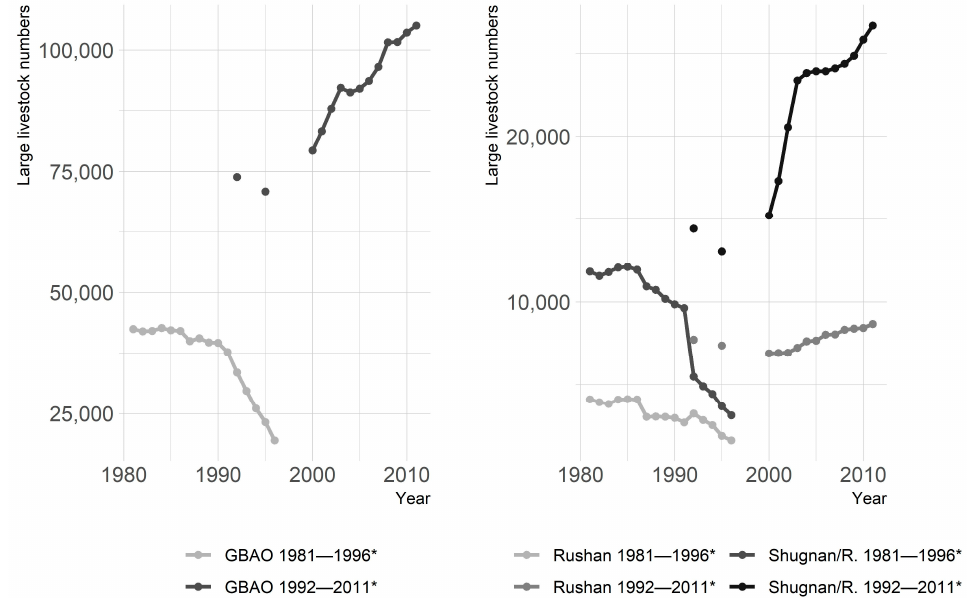
Figure 9. Time series of livestock numbers: the entire province of GBAO ( left ) and the dis- tricts of Shugnan/Roshtqala and Rushan ( right ; * indicates significant trends, p < 0.01; data sources: